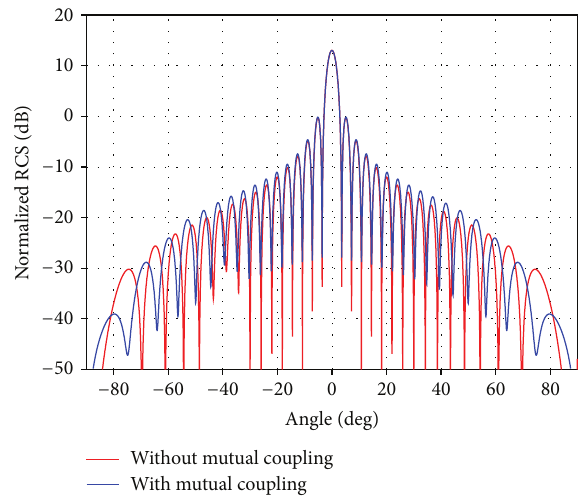
Figure 13: RCS of a parallel-in-echelon series-fed linear dipole array ( 𝑁 = 40 ) with Dolph-Chebyshev amplitude distribution ( 𝜃 𝑠 = 0 ∘